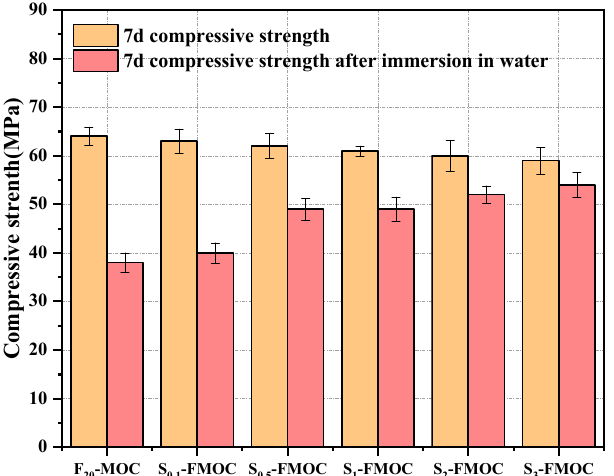
Figure 10. 7 d compressive strength of compound material–magnesium oxychloride cement composite ternary system.